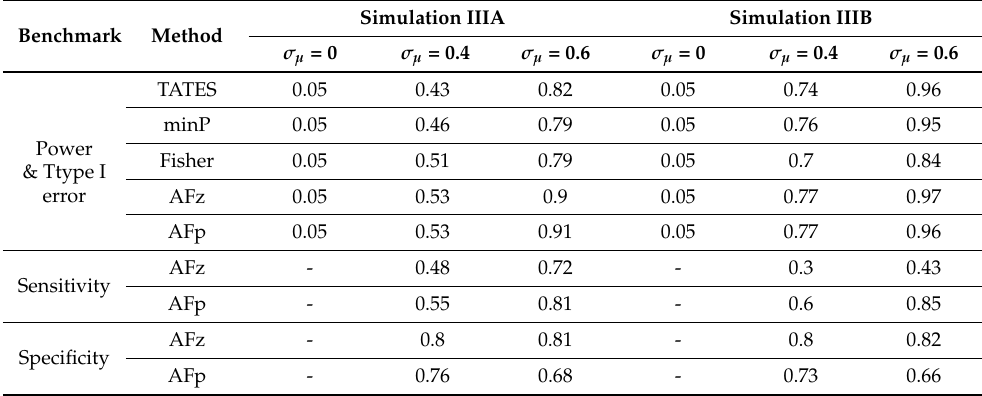
Table 2. Results of Simulations IIIA and IIIB when N 1 = 100. For σ µ = 0, the value indicates Type I error control, and for σ µ = 0.4 and 0.6, the value indicates